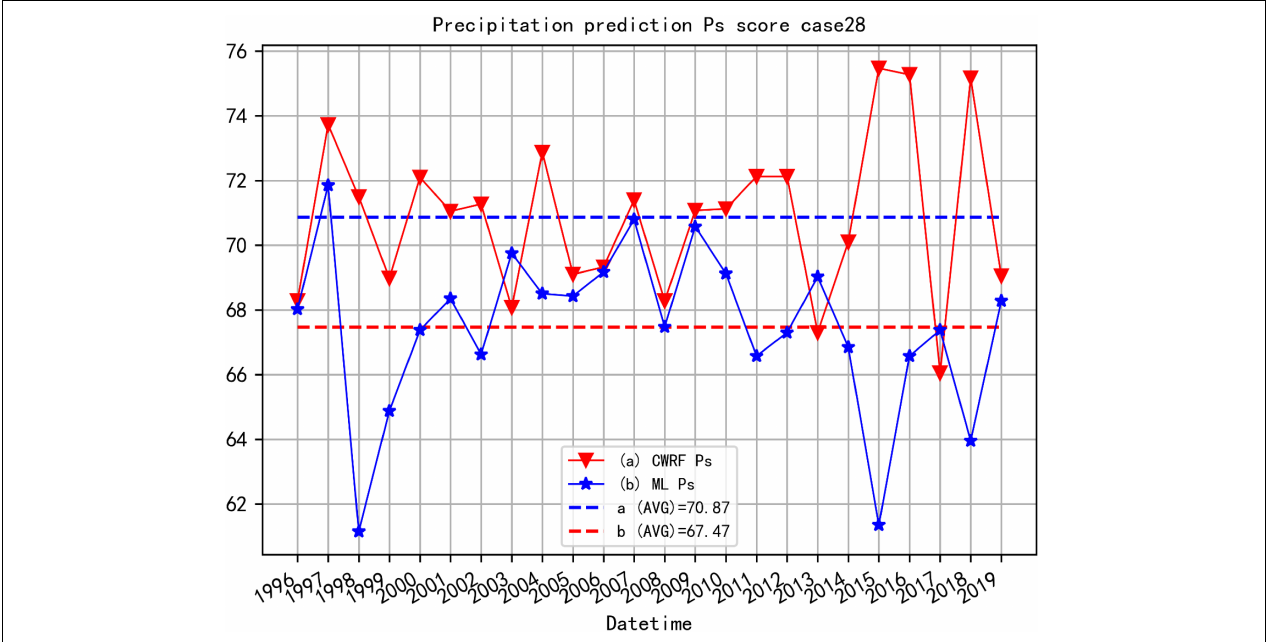
FIGURE 12 | Comparison of Ps before and after CWRF forecast correction for the 4 time-time sets of case 28. (a) CWRF forecast, (b) machine learning correction, and (a, b) mean Ps from 1996 to 2019.